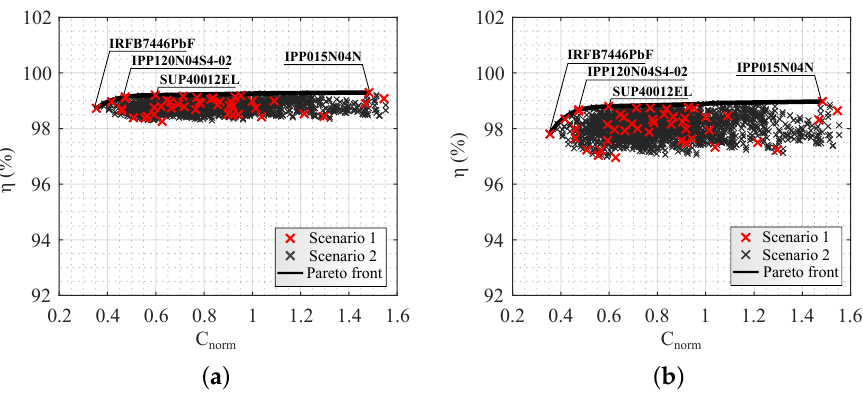
Figure 7. Pareto front for DM. ( a ) 500 W. ( b ) 800 W. In these, 2209 MOSFET combinations were evaluated. The Pareto front contains the optimal solutions for cost × efficiency. The part numbers on the front are shown in Tables 3 and 4 for the powers of 500 W and 800 W, respectively, identifying the normalized cost ( C norm ), efficiency ( η ) and junction temperature ( T J ) for each transistor. The highlighted rows identify the solutions of scenario 1, which uses the same part number in all MOSFETs. These part numbers are presented in Figure 7. Table 3. Design details for DM with 500 W.